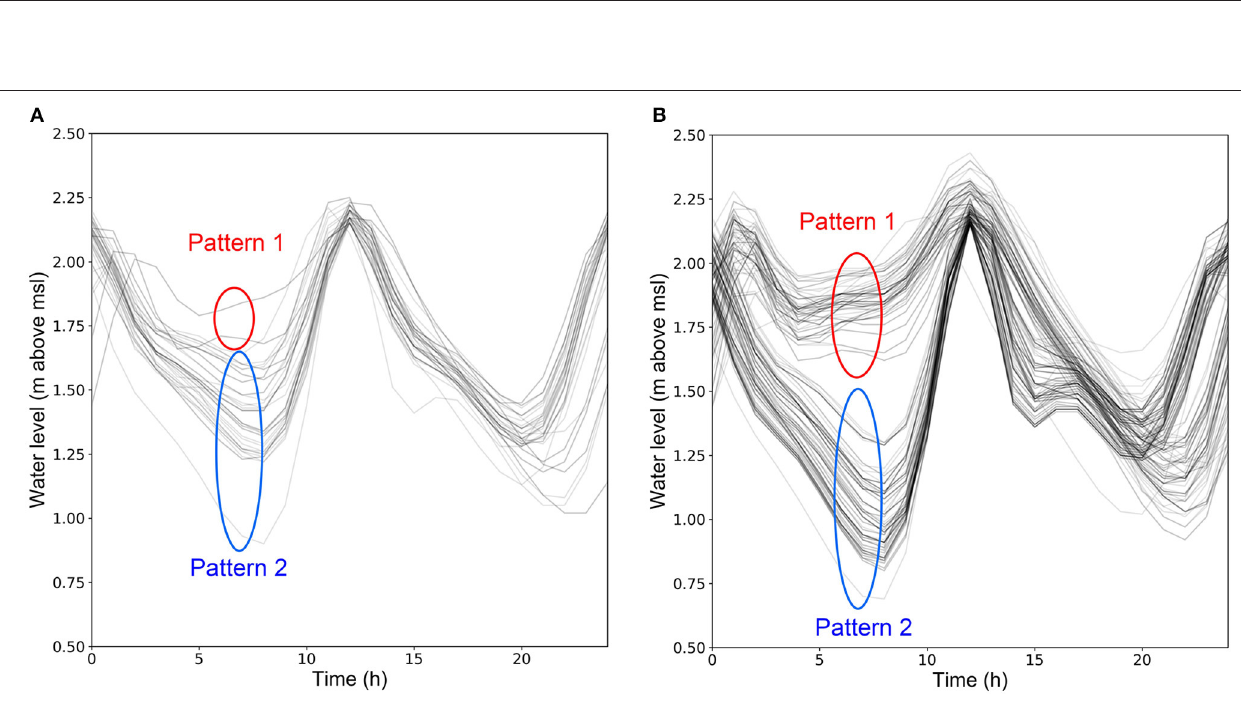
Frontiers in Climate |